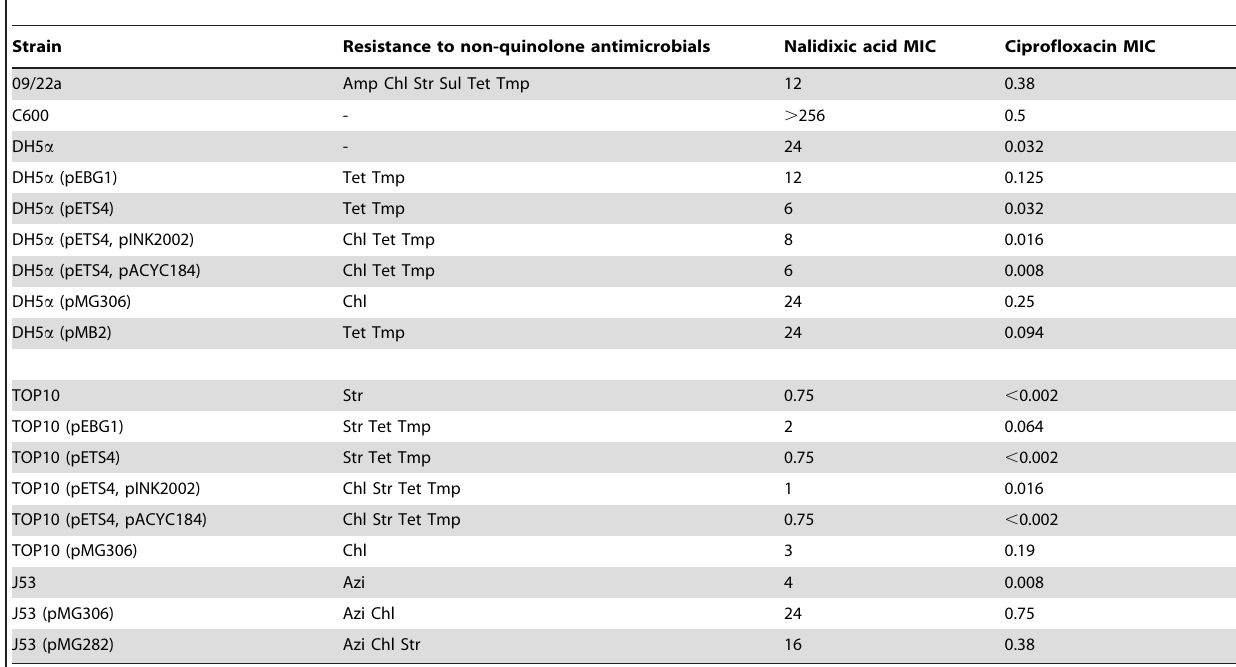
Table 4. MICs to quinolones conferred by pEBG1, its derivatives and other Qnr-encoding plasmids.